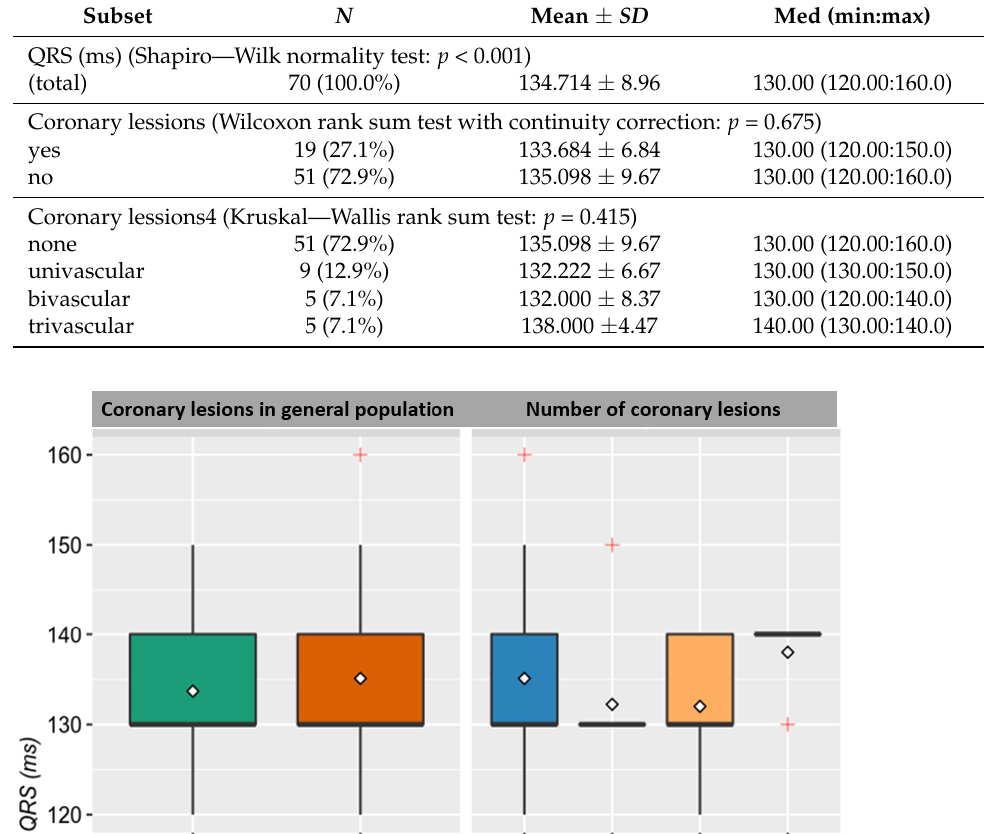
Table 3. Relationship between LBBB-QRS complex duration and magnitude of coronary impairment in patients with ischemic heart disease by macrovascular involvement.